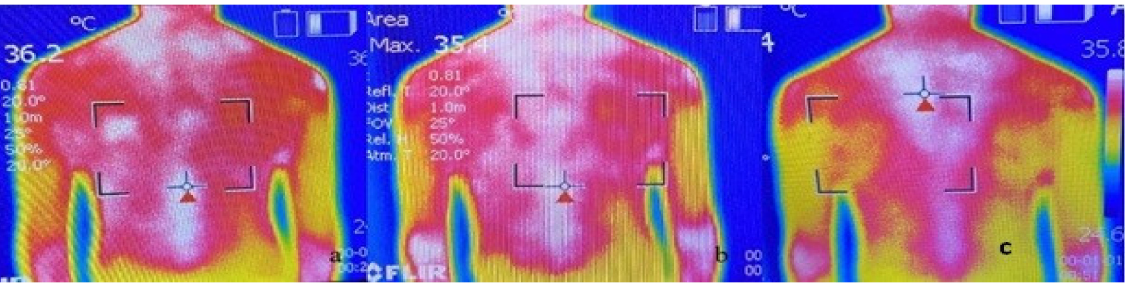
Figure 10. Subject with scoliosis 3 ( a ) image taken at the beginning of the experiment 1; ( b ) image taken at the end of the experiment 1; ( c ) image taken at the end of the experiment